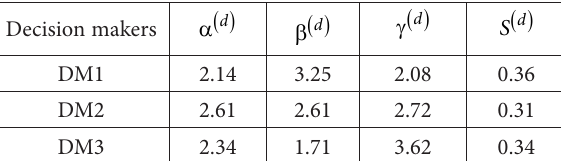
Table 5. Weights of decision makers